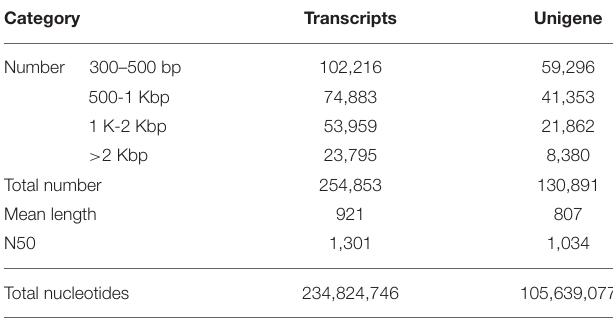
TABLE 1 | Summary of sequence assembling of C. rhombifolium transcriptome.